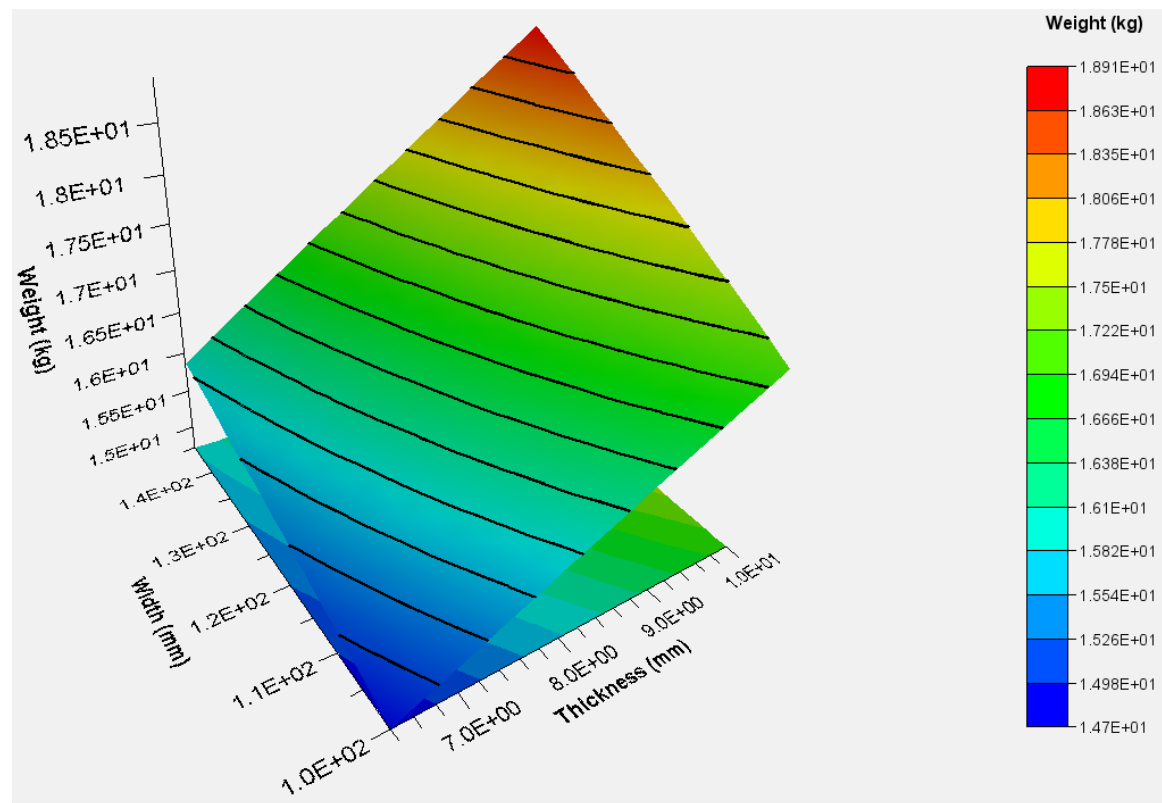
Figure 18. RSM for the weight of the NPT as functions of the thickness and width of spokes. Table 5. Optimization results achieved using three algorithms.